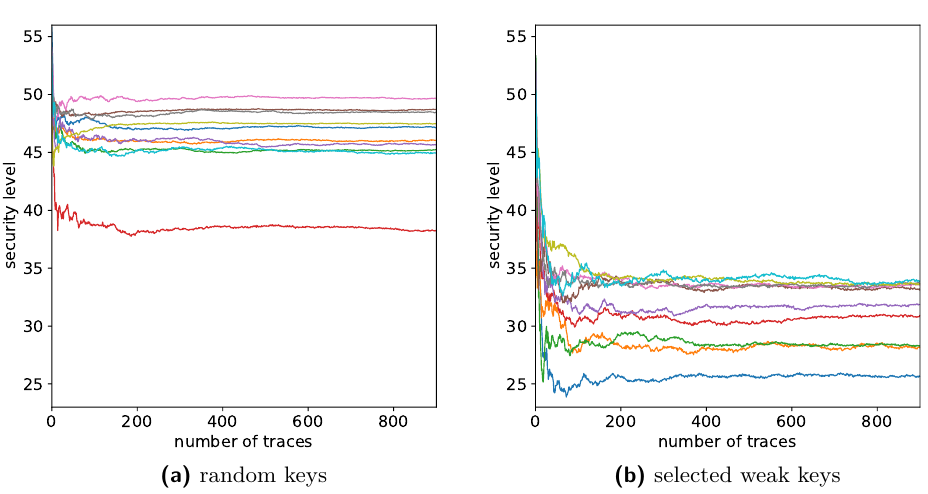
Figure 15: Dependence of the security levels of chosen keys on the number of used attack traces. Left: Ten randomly selected keys. Right: Ten selected keys with low security